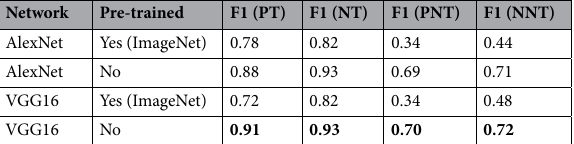
Table 3. F1 score on cell detection using different neural networks and strategies. Significant values are in